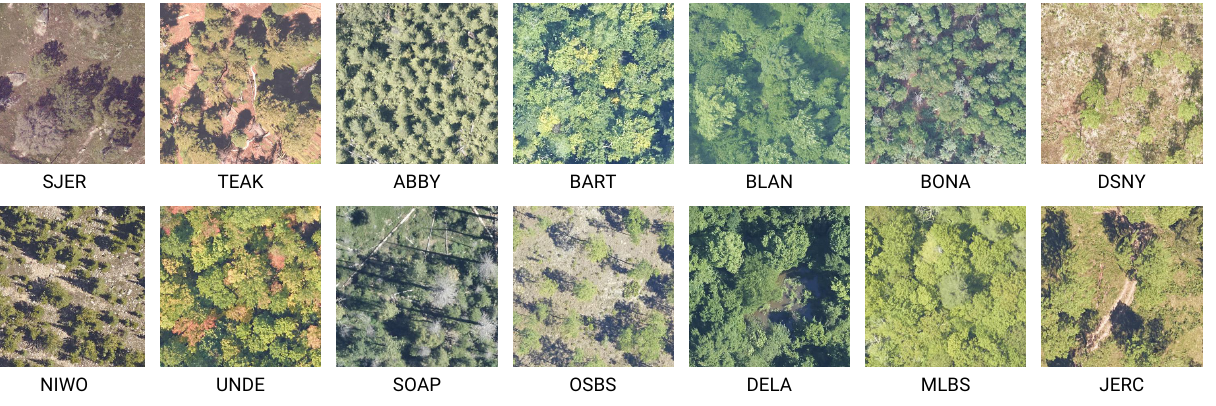
Figure 8. Examples of the test images in NeonTreeEvaluation Dataset [16]. The four-letter captions under the images are abbreviations of the site names. The forest types vary across different